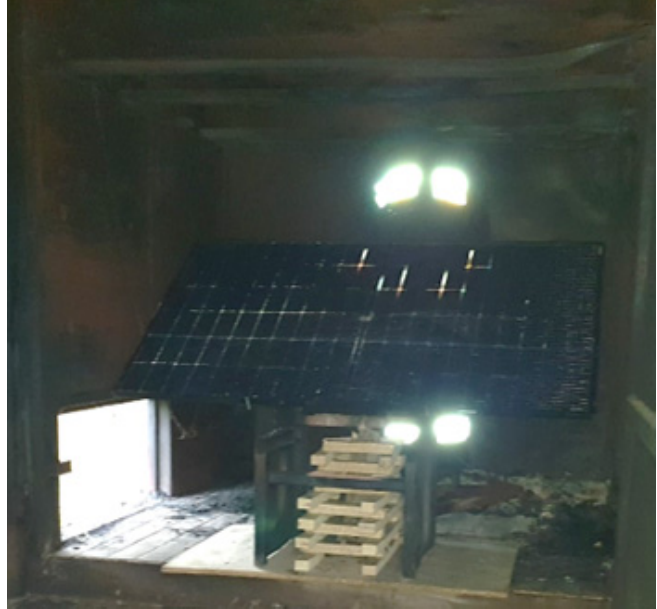
Figure 4. Scenario Test 2 with a PV module fire in a closed space.